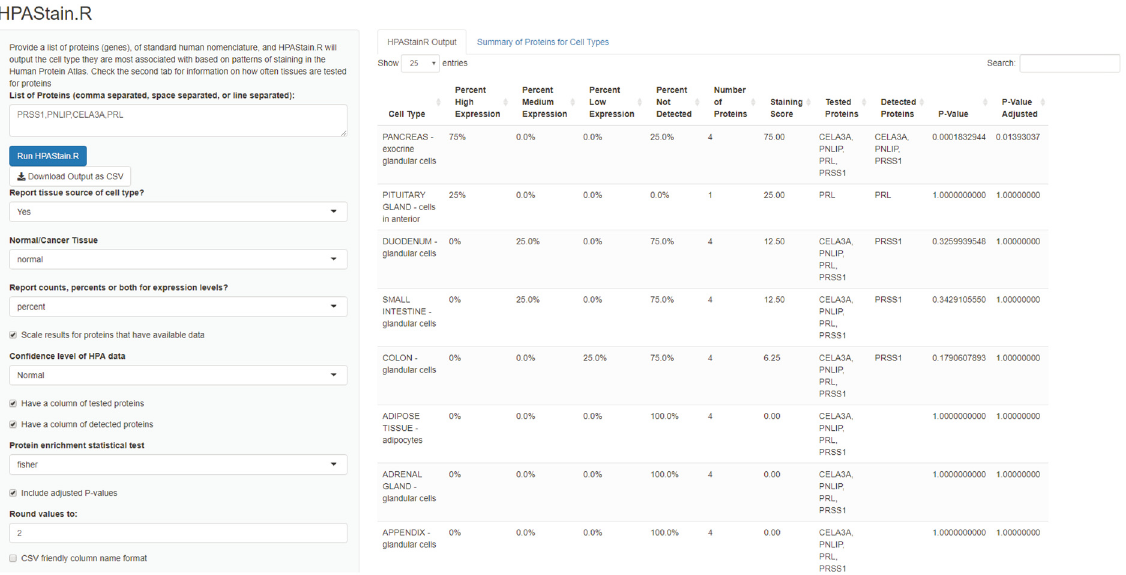
Figure 4. A screen shot of the user interface of HPAStainR. A list of comma, space, or line separated proteins or genes are inputted on the left column. Multiple customizations are available for users below to optimize the search parameters for their query of interest. Data is outputted to the right, and further information about the cell types and how many proteins were histologically scored per cell type are available as a second tab.